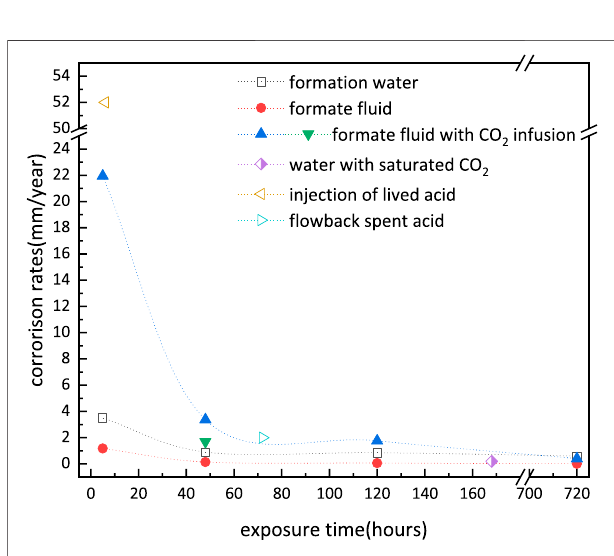
FIGURE14| ComparisonofmeasureduniformcorrosionratesofS13Cr with data obtained from the literature under ultra-deep downhole conditions (180 °